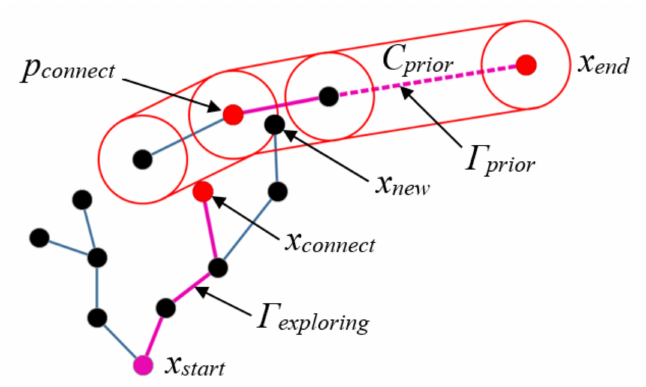
Figure 11. Γ prior and Γ exploring .